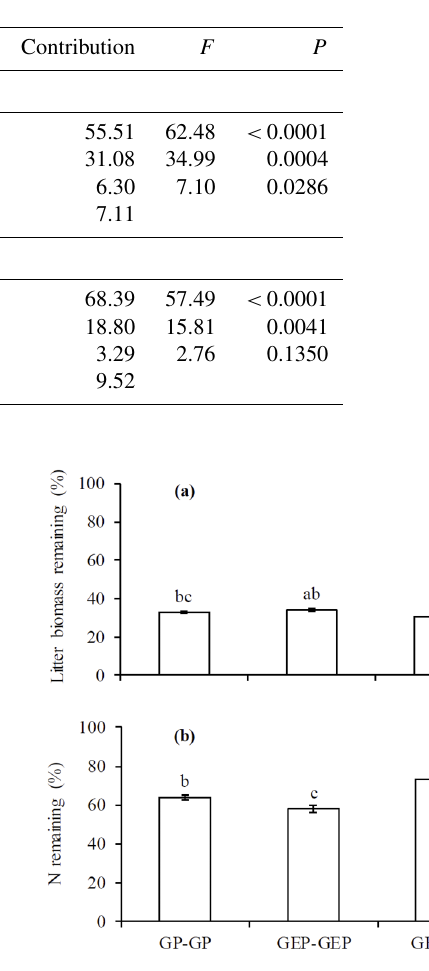
Table 3. Contribution (%) of incubation site (site: GP, grazing paddocks; GEP, grazing exclusion paddocks) and litter quality (quality: GP litter, mixed litter collected from grazing paddocks; GEP litter, mixed litter collected from grazing exclusion paddocks) to litter decomposition and N release.